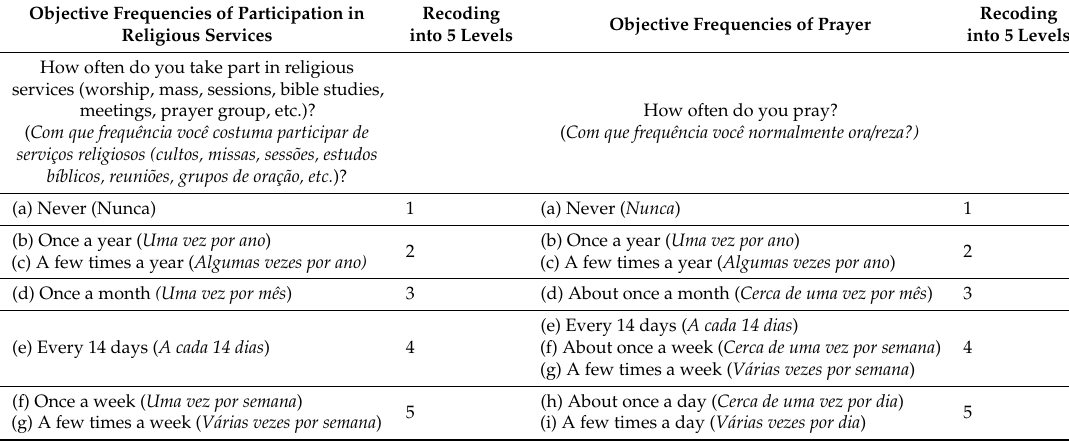
Table 2. Recoding of objective frequencies of the items concerning prayer, meditation, and religious services into five score levels. Adapted from Huber and Huber (2012, p.